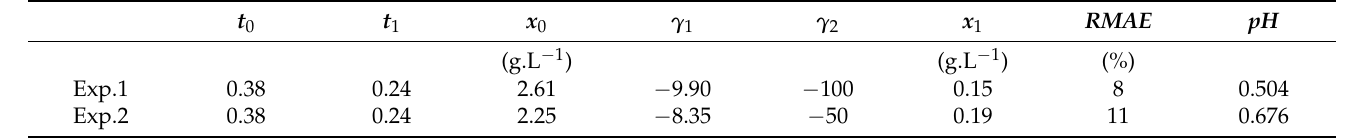
Table 10. Least squares fitting of the exponential model parameters 1 (see Equation (15)).